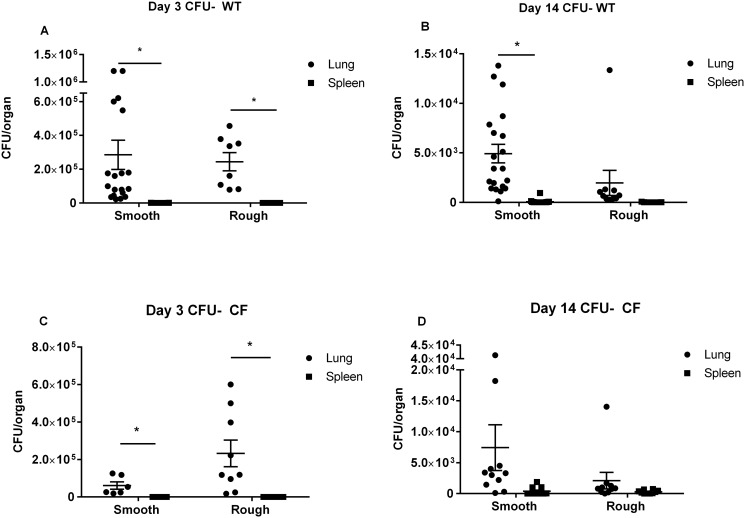
Pulmonary and splenic CFU.(A, B, C and D) Intratracheal inoculation with M. abscessus (smooth and rough morphotypes) suspended in fibrin plugs results in predominance of pulmonary infection with minimal systemic infection. (N = 9–20 mice in each group at 3 and 14 day time points). * p< 0.05. Data displayed as mean ± SEM of group, pooled from 2–3 replicate experiments for each morphotype.